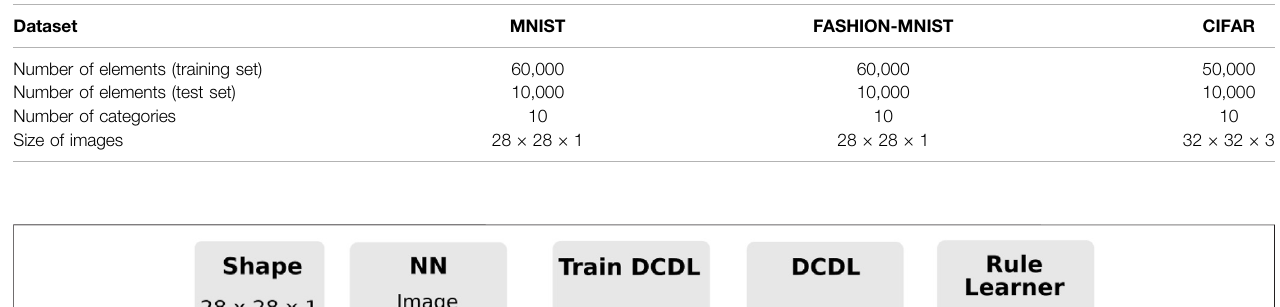
TABLE 1 | Statistics of the datasets.